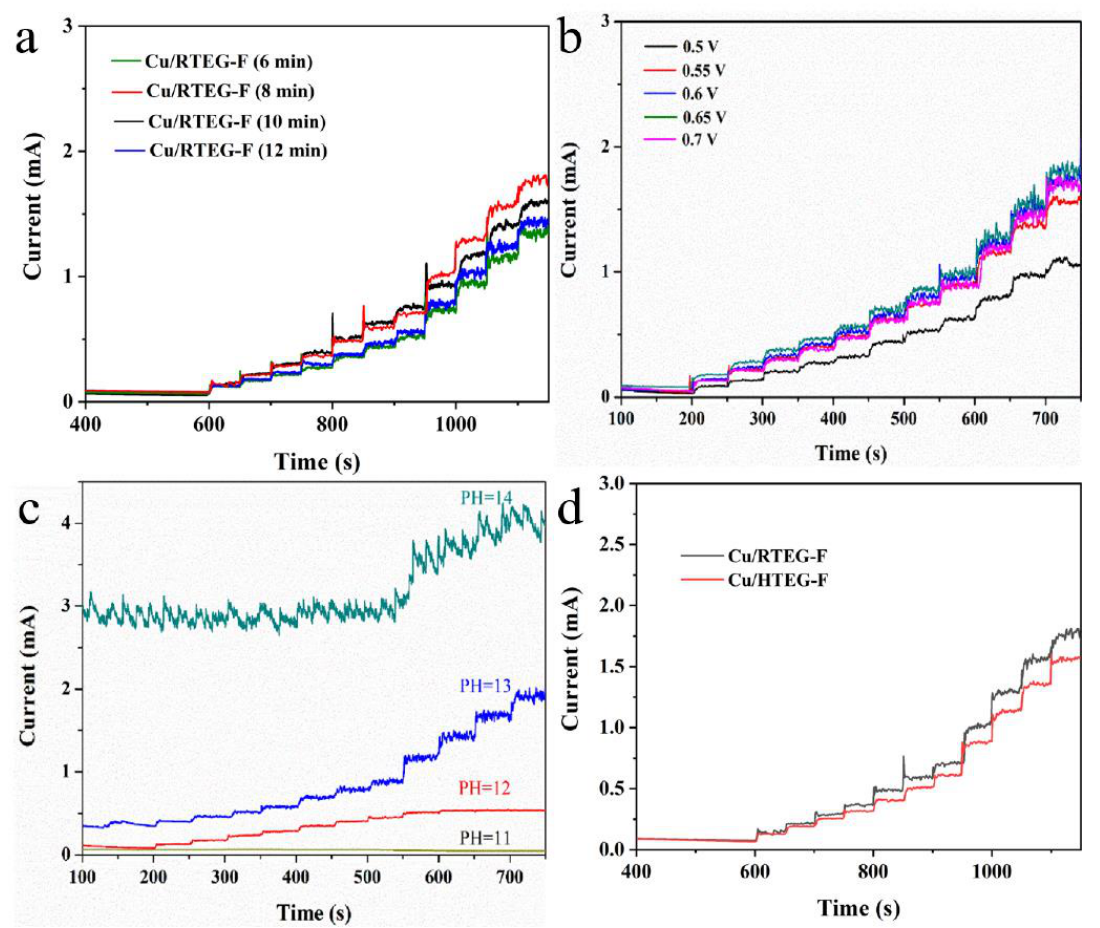
Figure 2. ( a ) Amperometric responses of Cu/RTEG-F electrodes prepared at four electrodeposition times (6 min, 8 min, 10 min, 12 min) with successive additions of glucose into 0.1 M NaOH every 50 s at 0.65 V. ( b ) Amperometric responses of Cu/RTEG-F electrodes deposited for 8 min with continuous infusion of glucose in 0.1 M NaOH at various potentials (0.5–0.7 V). ( c ) Amperometric responses of Cu/RTEG-F electrodes deposited for 8 min with continuous infusion of glucose at various pH from 11 to 14. ( d ) Amperometric responses of Cu/RTEG-F electrode and Cu/RTEG-F electrode deposited for 8 min with continuous infusion of glucose into 0.1 M NaOH every 50 s at 0.65 V. Figure 3b shows the CV curves of Cu/RTEG-F electrode at different scanning rates in NaOH solution containing 1.0 mM glucose. The oxidation peak appears at the potential of 0.52 V and the peak current increases with the increase of sweep speed. The inset curve shows that the peak current (I) was proportional to the square root of scanning rate (V 1/2 ), illustrating that the reaction of glucose at the Cu/RTEG-F electrode is a diffusion-controlled route [31]. Figure 3c shows the amperometric current response of glucose at various concentrations by putting into 0.1 M NaOH. The Cu/RTEG-F electrode reacted rapidly and reached a stable current plateau. The lines in Figure 3d show the relationship between the concentration and the current of glucose. The sensor demonstrates a high sensitivity